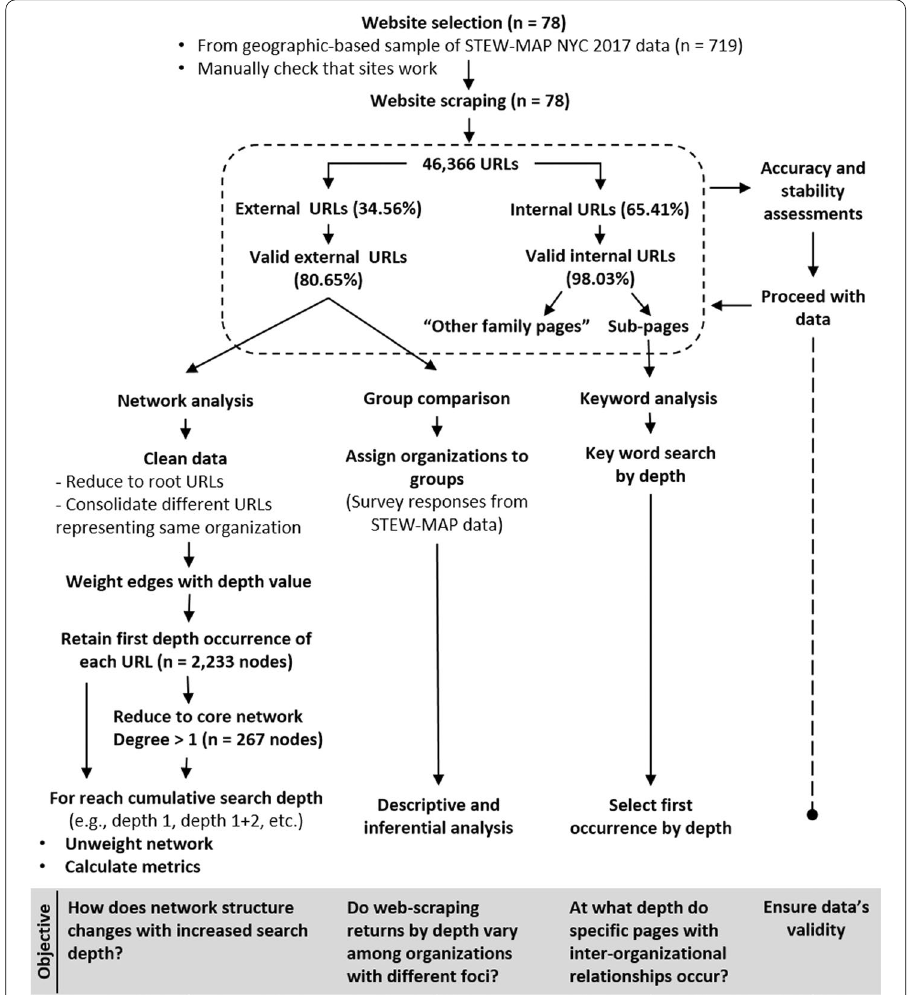
Fig. 1 Summary of workflow and data preparation. External links connect to web pages with a different root URL than the searched site, while internal links connect to web pages with same root URL. Valid returns are working websites with a URL status code 200. Internal pages can be family or sub- pages, which is relative to the search URL as explained in the